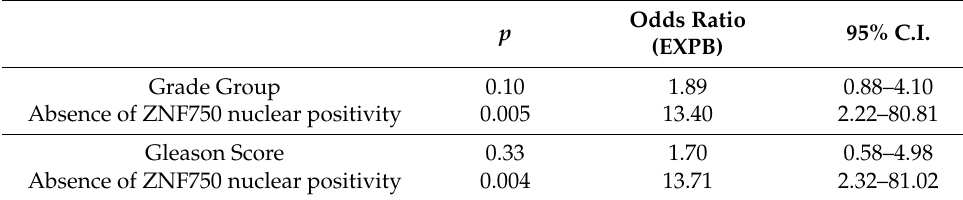
Table 3. Odds ratio of risk of metastasis in patients with prostatic acinar adenocarcinomas . p Odds Ratio (EXPB) 95% C.I.